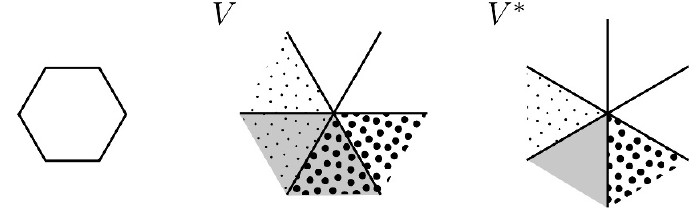
Figure 14 . Another example of theorem